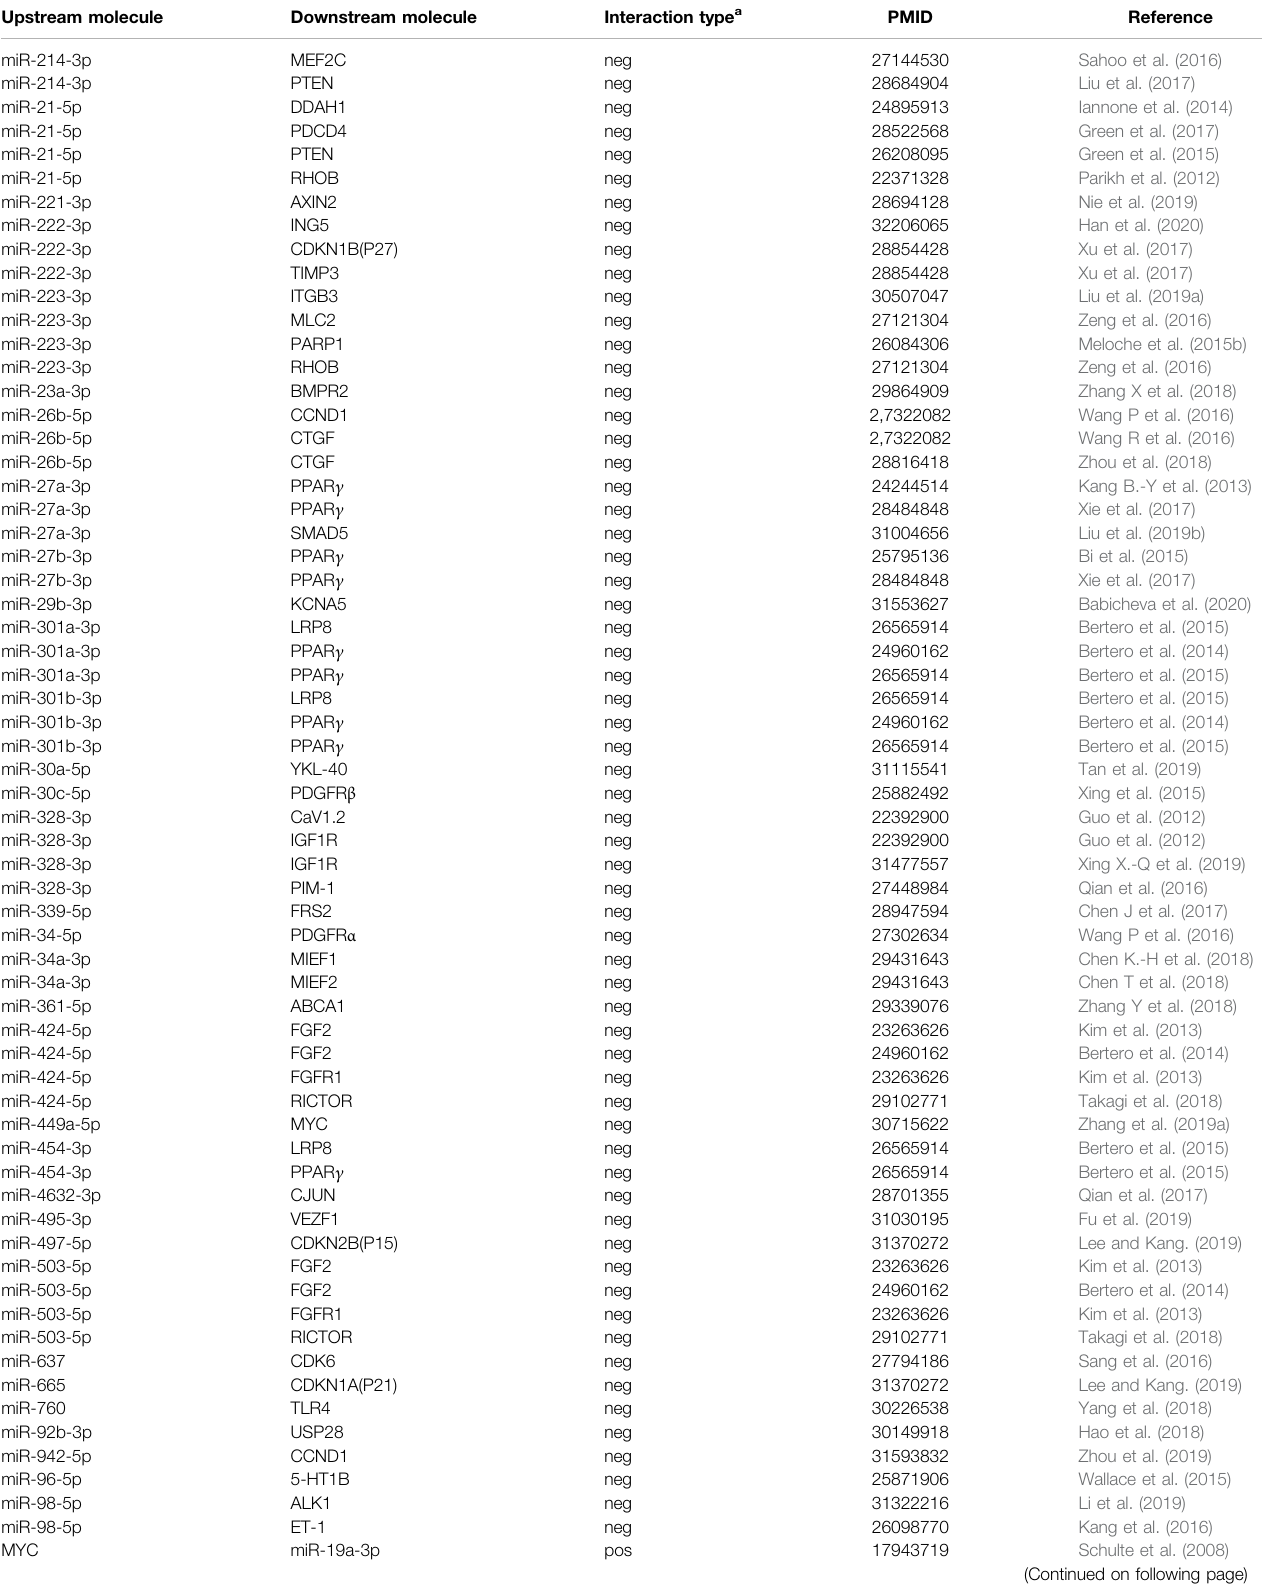
TABLE 2 | ( Continued ) List of network